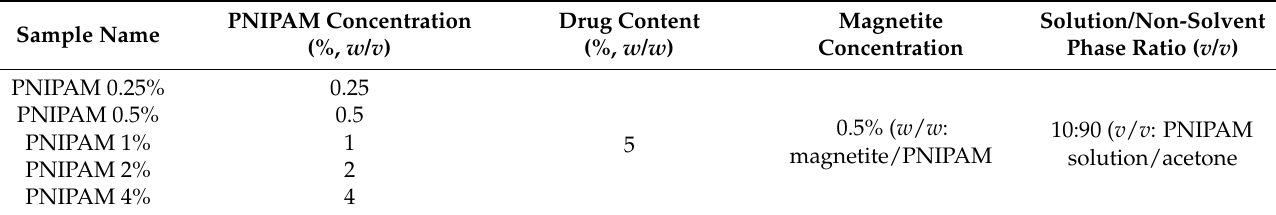
Table 1. Composition of PNIPAM/magnetite